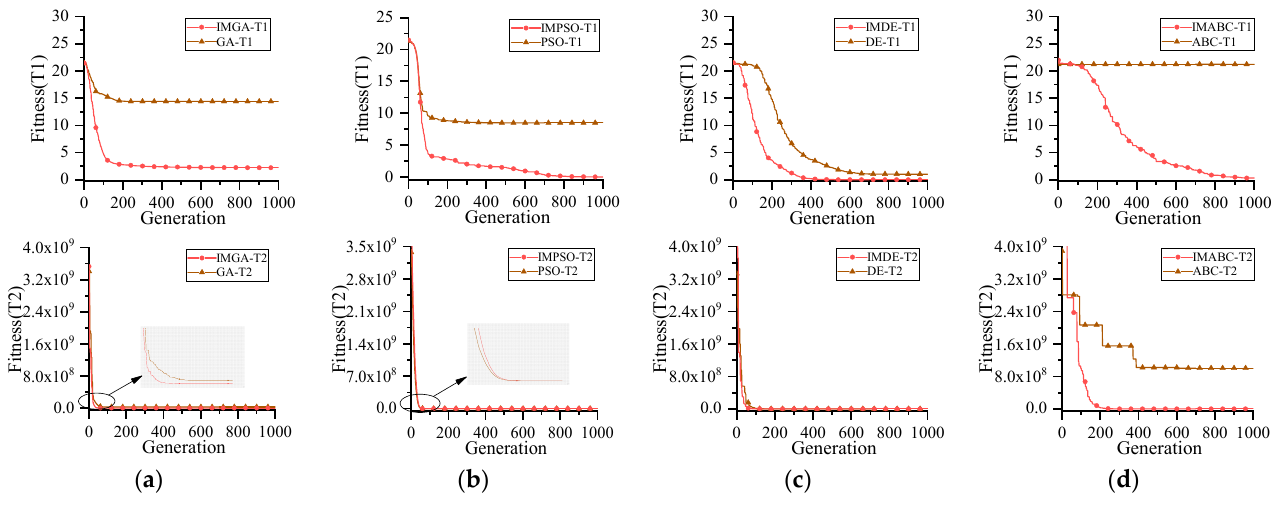
Figure 5. Convergence traces of IMTO and baseline solvers on multitasking problem P 5 in test suite 1. ( a ) Convergence traces of IMGA and B-GA, (b ) Convergence traces of IMPSO and B-PSO, ( c ) Convergence traces of IMDE and B-DE, and ( d ) Convergence traces of IMABC and